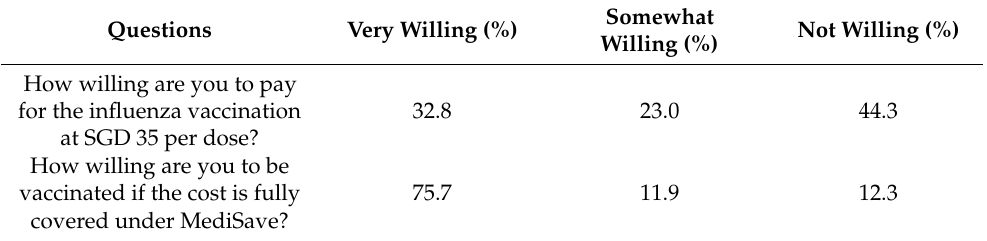
Table 5. Willingness-to-pay (N = 235).